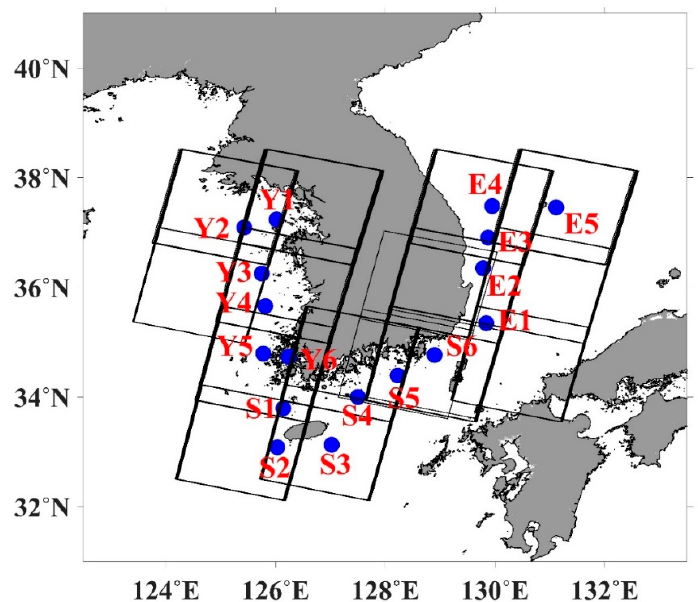
Distribution (black boxes) of the Landsat 8 OLI / TIRS images including the Korea Meteorological Administration (KMA) marine meteorological buoys from 1 April 2013 to 31 August 2017, where the blue circles and the red text around the circles indicate the location and symbol of the KMA marine meteorological buoys, respectively.